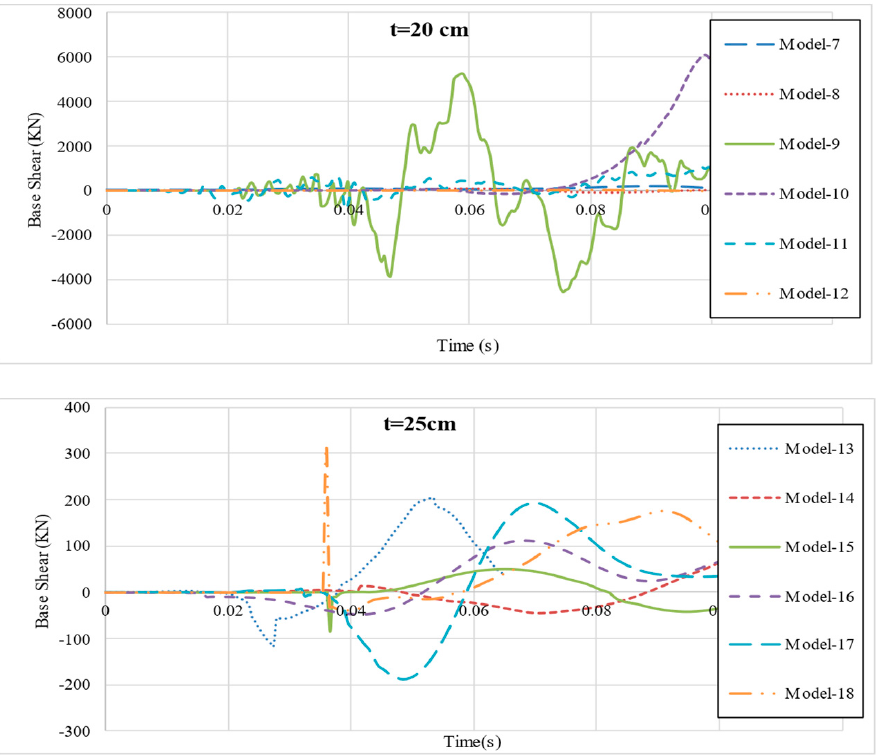
Figure 12. Base shear of the wall with thicknesses of 15, 20, and 25 cm.